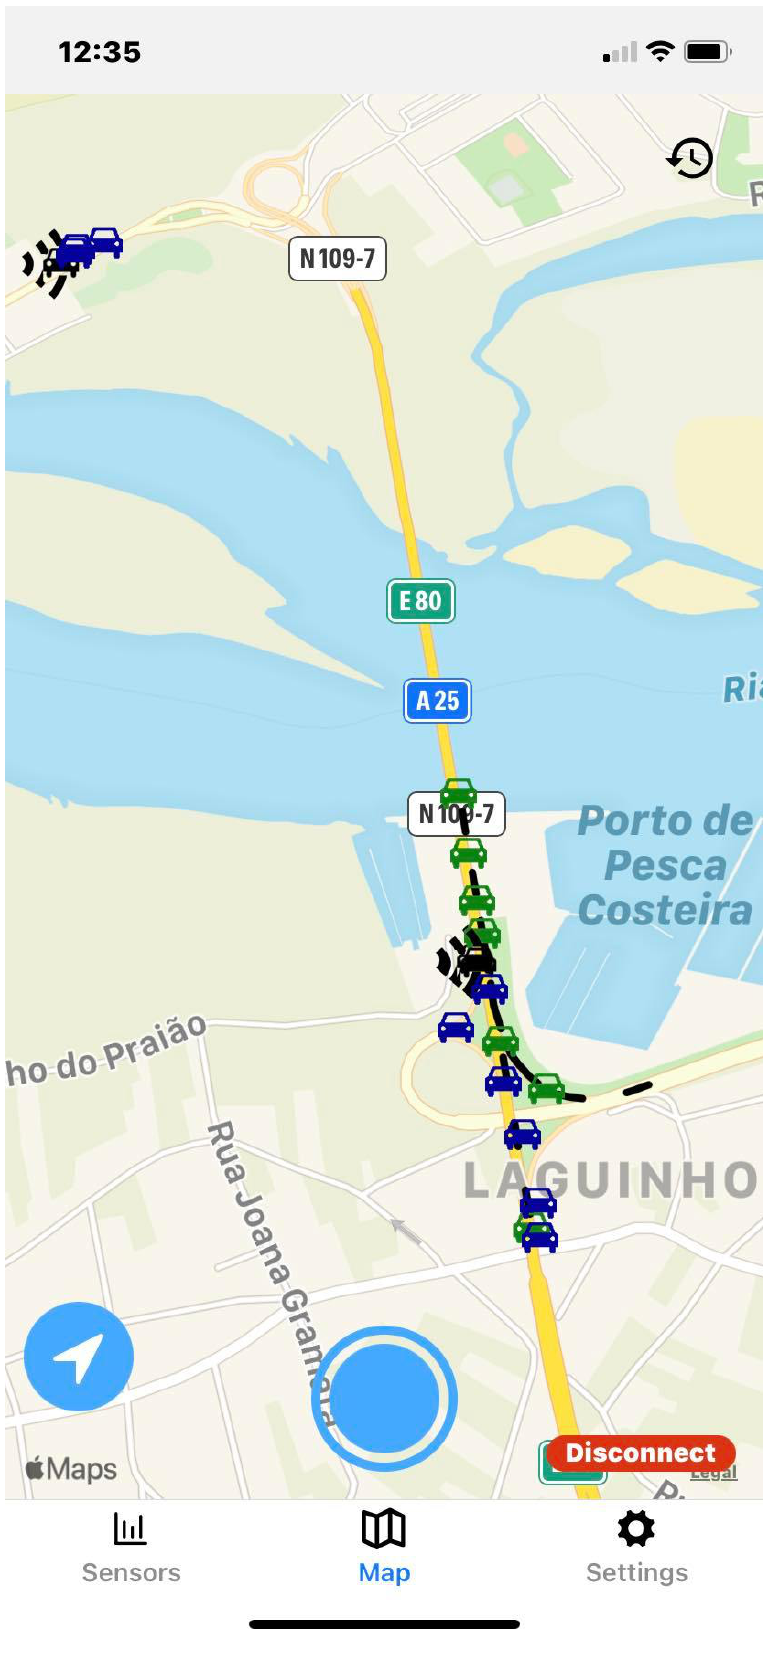
Figure 8. CAM and CPM message representation in the mobile